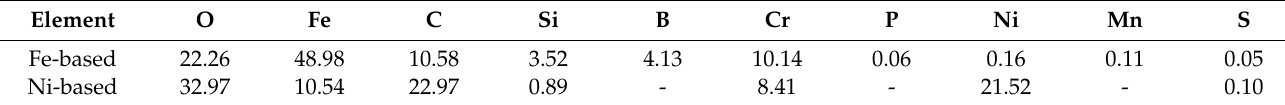
Table 6. Alloy coating atoms for each element content (wt%).